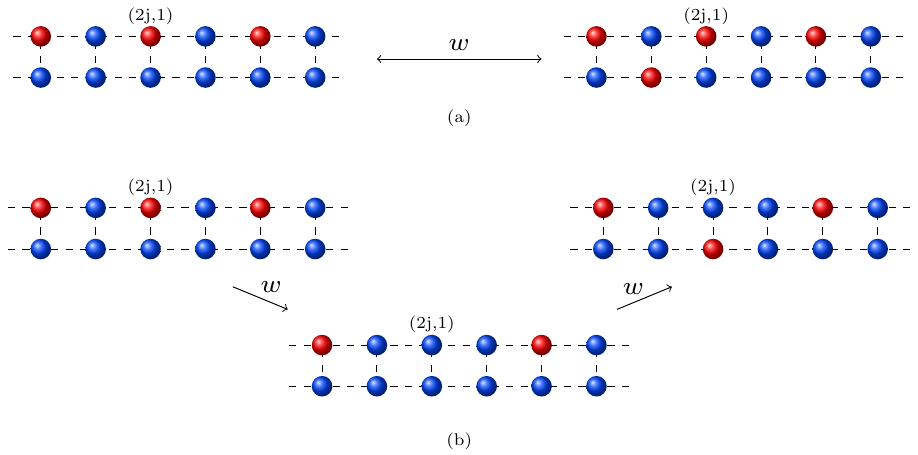
Figure 4: Schematic representation of the virtual processes leading to the effective Hamiltonian H ′ . The red (blue) circles represent atoms in Rydberg excited (ground) states. (a): The process which favors all Rydberg excitations to be on the even sites of one of the chains (chosen to be the top chain ( ℓ = 1) here) and leads to the first term in H ′ . The excited state constitutes one additional Rydberg excitation on an odd site of the bottom chain as shown schematically. (b) The competing virtual process which leads to the second term of H ′ . The excited state, which belongs to the high energy manifold, constitutes one additional Rydberg atom in its ground state at an even site of the top chain as shown. See text for